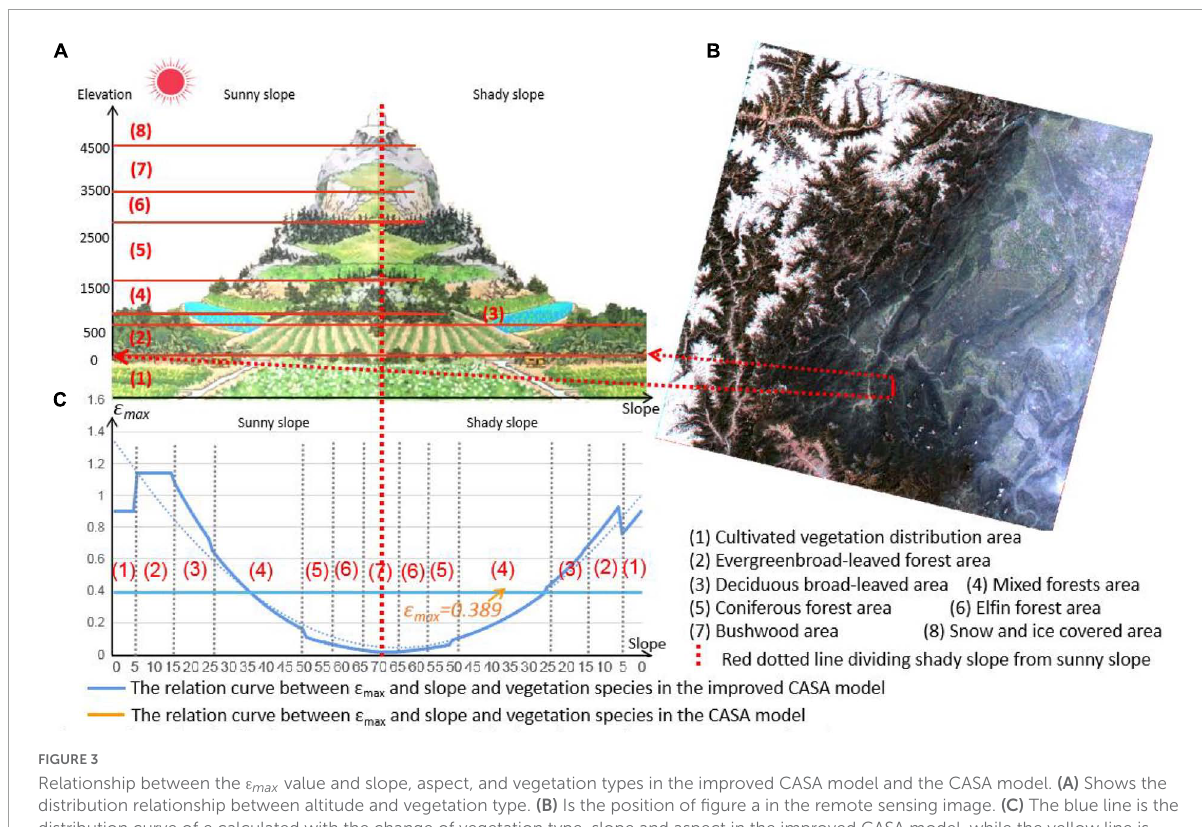
FIGURE3 Relationship between the ε max value and slope, aspect, and vegetation types in the improved CASA model and the CASA model. (A) Shows the distribution relationship between altitude and vegetation type. (B) Is the position of figure a in the remote sensing image. (C) The blue line is the distribution curve of e calculated with the change of vegetation type, slope and aspect in the improved CASA model, while the yellow line is fixed value of e determined with the change of vegetation type, slope and aspect in the original.